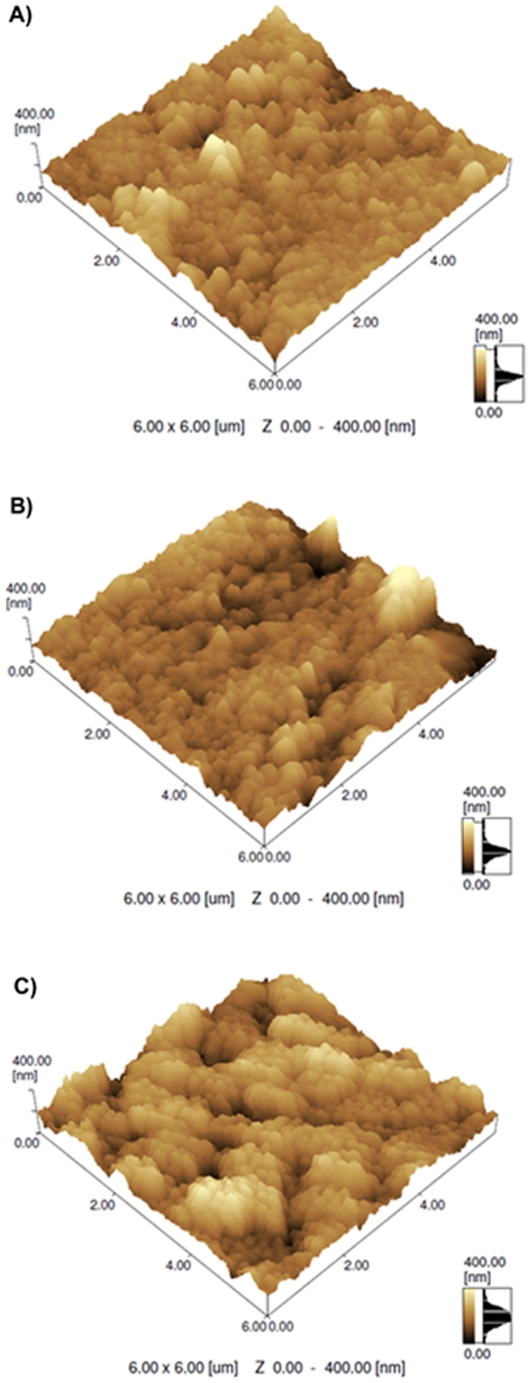
AFM topographical images of modified graphite electrode with poly(3-HPA).(A) Without biomolecules; (B) polymeric film after immobilization of the synthetic peptide Am1, and (C) agglutination process (Am1:IgG+).